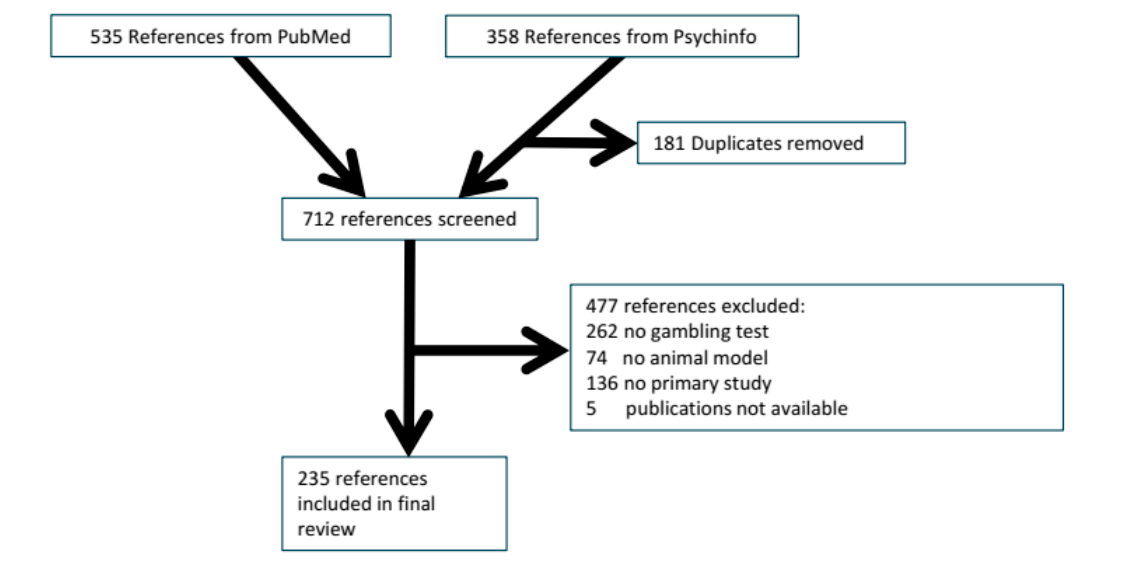
Figure 1. Flow scheme of references.